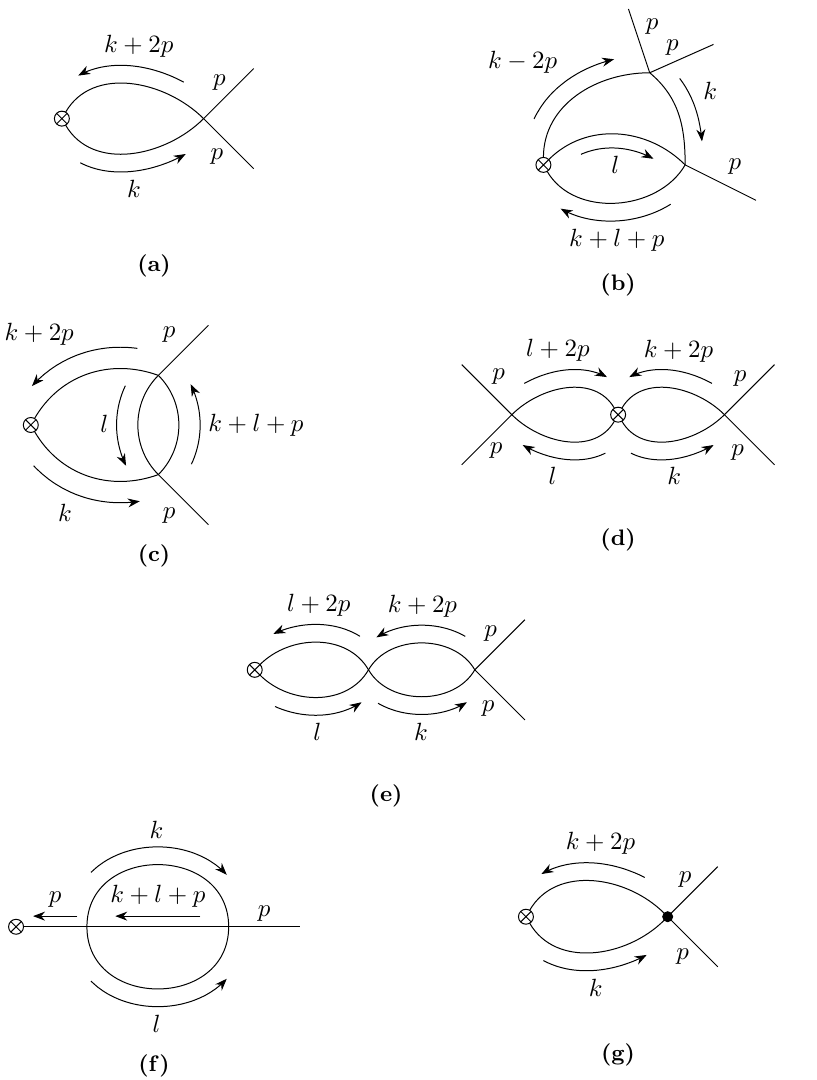
Figure 2. Feynman diagrams that contribute at